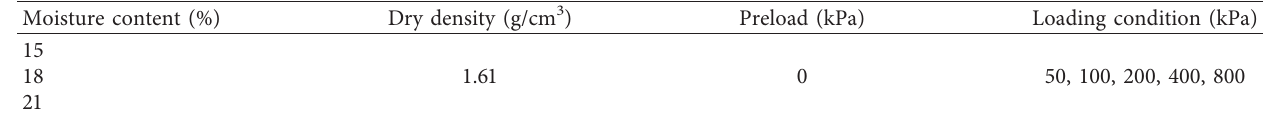
Figure 3: WG type single-lever consolidation instrument (medium pressure). Table 3: Creep test schemes with different moisture content.